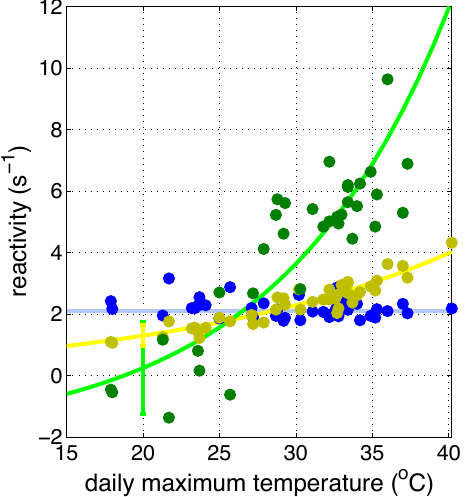
Fig. 2. Daily average (10:00–14:00LT) organic reactivity (s − 1 ) versus the daily maximum temperature ( ◦ C) with fits: temperature-independent 6 i VOCR i (blue), temperature-dependent 6 i VOCR i (yellow), and temperature-dependent VOCR (green). The temperature-dependent VOCR is equal to the measured OH reactivity minus the temperature-independent 6 i VOCR i and minus the OH reactivities of NO 2 , NO, HONO, HNO 3 , NH 3 , and SO 2 . The mean temperature-independent 6 i VOCR i is 2.1 ± 0.3 1 (1 σ ) (light blue line). The unknown reactivity is thus temperature- dependent and is the difference between the yellow and green curves. The error bars are the sum of the squared y residuals (divided by the number of points less 2) and are ± 0.3 4 (yellow) and ± 1.5